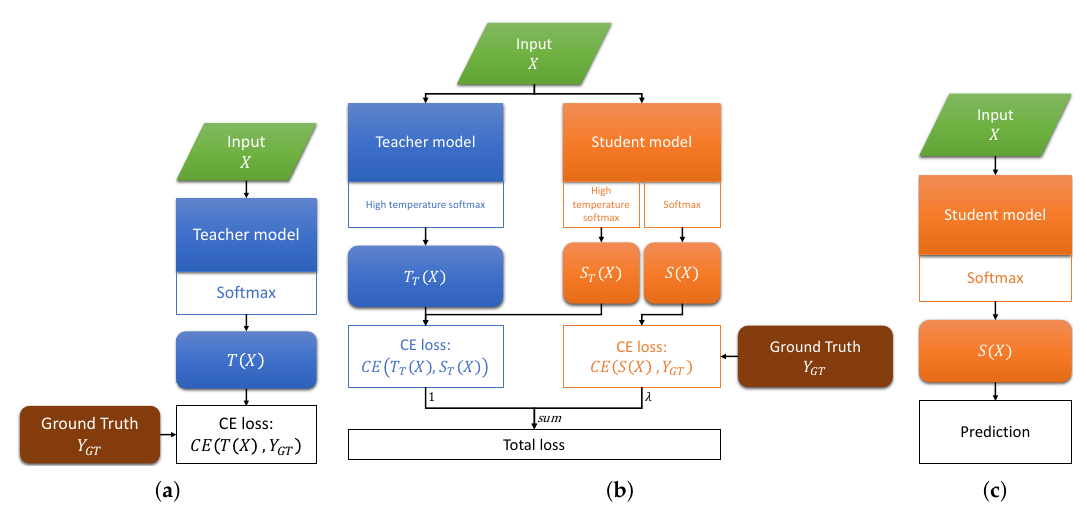
Figure 2. ( a ) Train the teacher model directly on dataset; ( b ) The process of KD training. The student model output two branches: high-temperature softmax output distill knowledge from the teacher model and the normal softmax output learn to match the ground truth label; ( c ) In prediction mode or production environment, the trained student model only output normal softmax result.